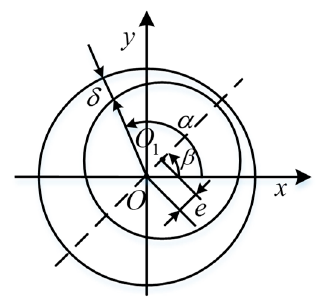
Figure 3. Schematic diagram of air gap eccentricity.